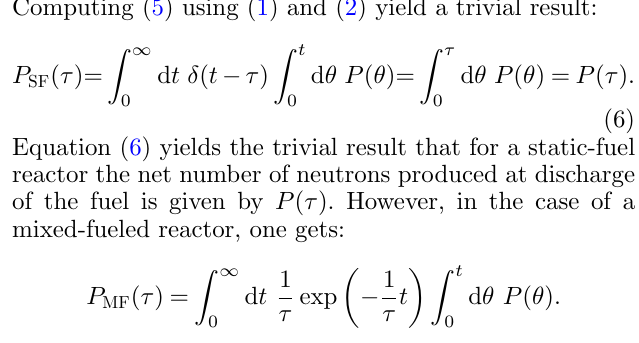
Fig. 3. Evolution of the neutron production ( ν Σ f ) and absorp- tion macroscopic cross-sections as well as cell k ∞ as function of the total fluence for the NaCl UCl (68–32mol%) 3